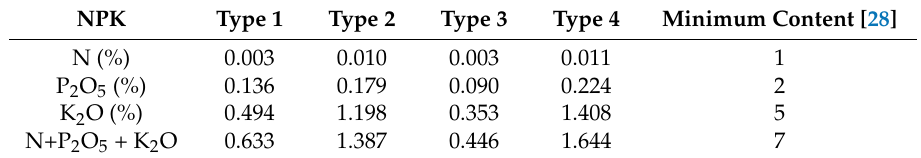
Table 5. NPK contents in the ash and minimum content of NPK for the ash qualification to